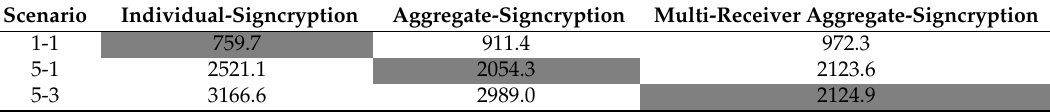
Table 6. Comparisons of total times (in ms) of different approaches for one smart camera/one monitoring device (1-1), five smart cameras/one monitoring device (5-1) and five smart cameras and three monitoring devices